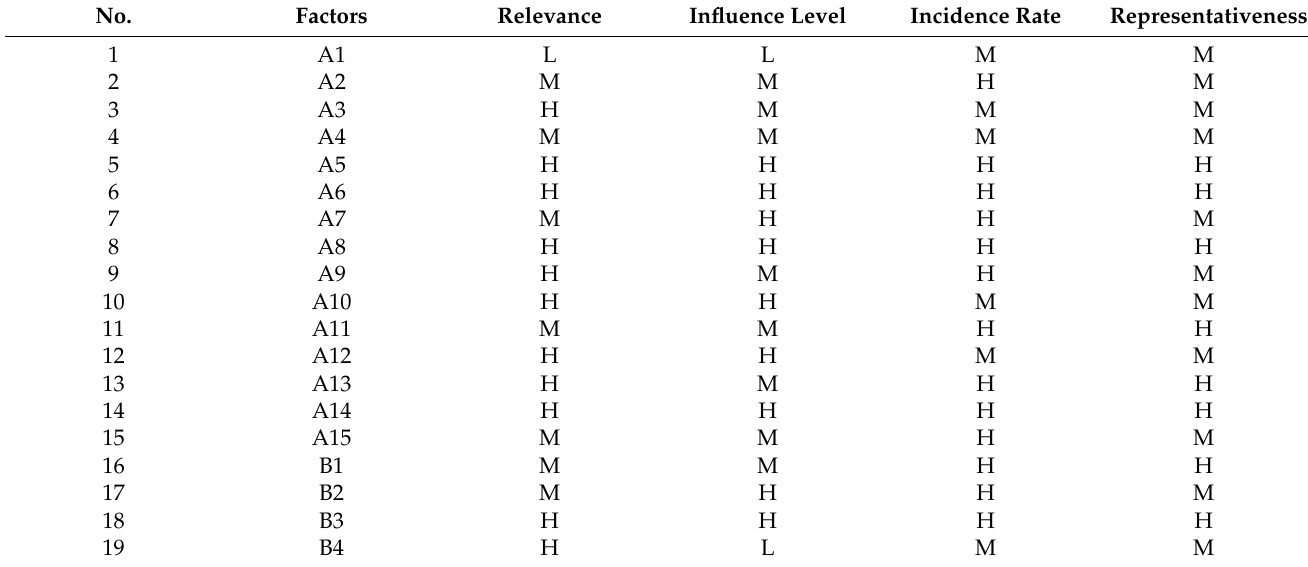
Table 4. The results of the decision-making team’s